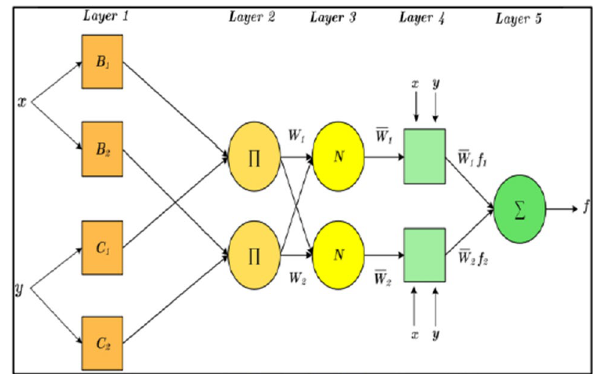
Fig. 3 Schematic of the ANFIS model